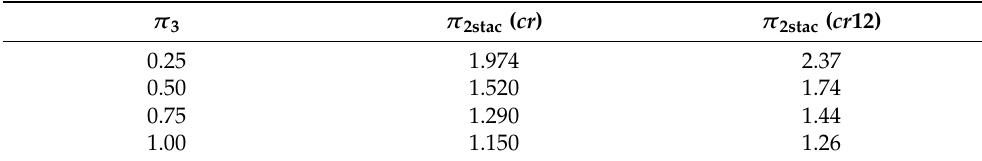
Figure 12. Dependence of π 2stac and ( ∆ Ex /( C 1 T ok )) max on π T and π 3. Table 1. Dependence of π 2stac on π 3 for recuperators cr and cr